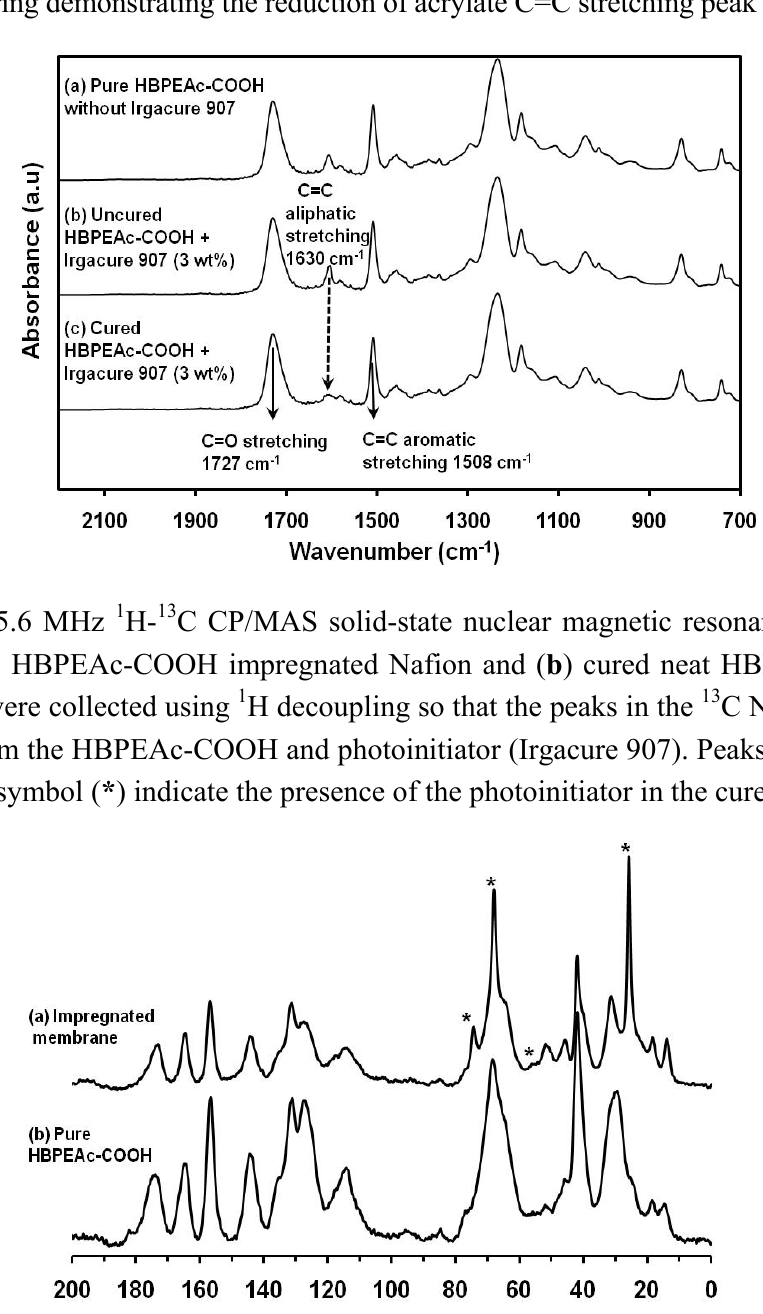
Figure 2. Fourier transform infrared (FTIR) spectra of ( a ) pure HBPEAc-COOH without initiator; ( b ) pure HBPEAc-COOH with initiator before curing; and ( c ) pure HBPEAc-COOH after photocuring demonstrating the reduction of acrylate C=C stretching peak at 1,630 cm − 1 .